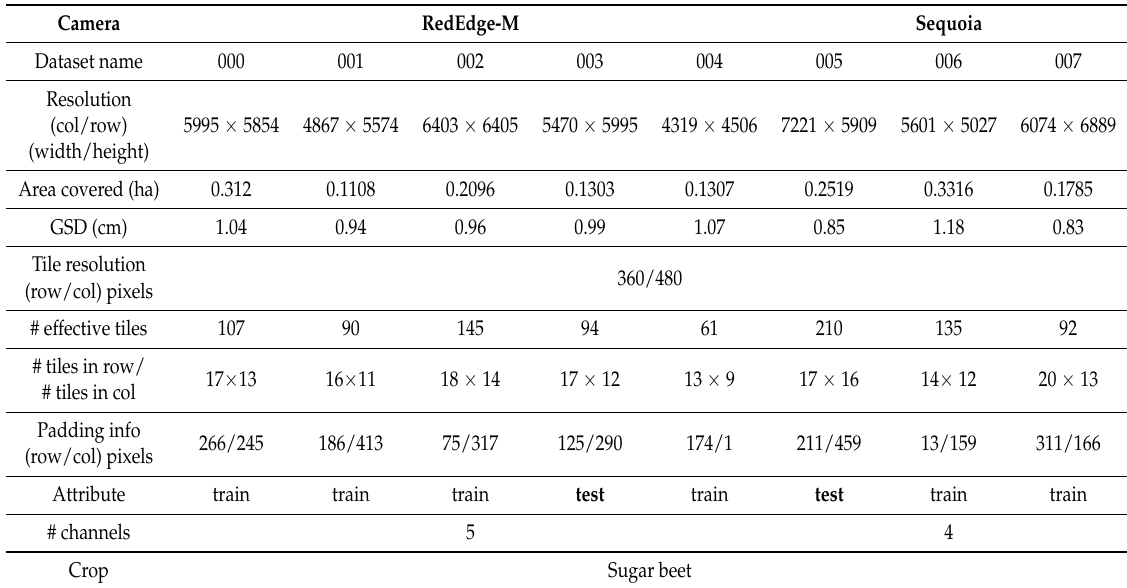
Table 1. Detail of training and testing